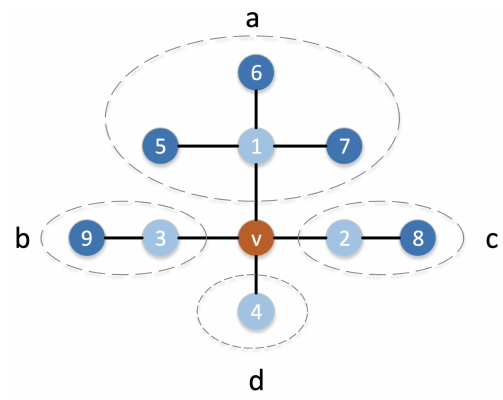
Figure 2. A network used to express the importance of degree ratio in the spread of